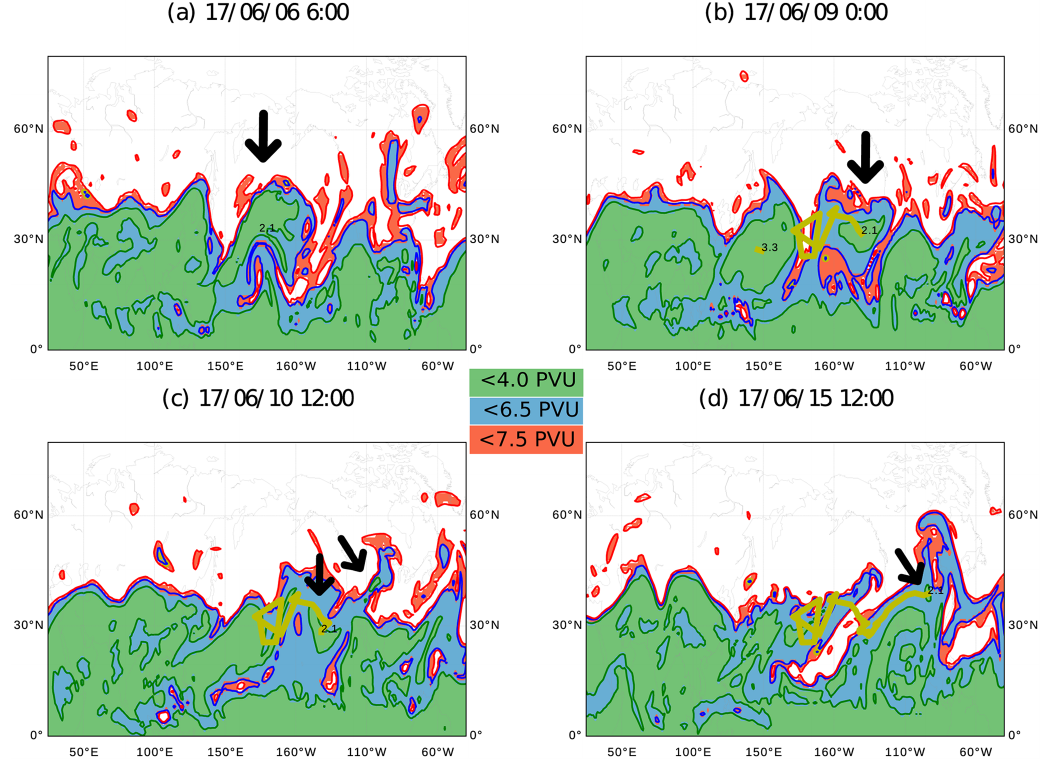
Figure 3. Example of the indirect transport pathway from the ASMA into the lower stratosphere by two eastward shed cutoffs from the ASMA at 380K. Colours are as in Fig. 2. Yellow lines show tracks of the 4.0PVU cutoffs. The largest cutoff (3.26% of NH area) remains for only a very short time over the western Pacific. The smaller cutoff (2.12% of the NH area) has a very long lifetime of about 1 week and travels to North